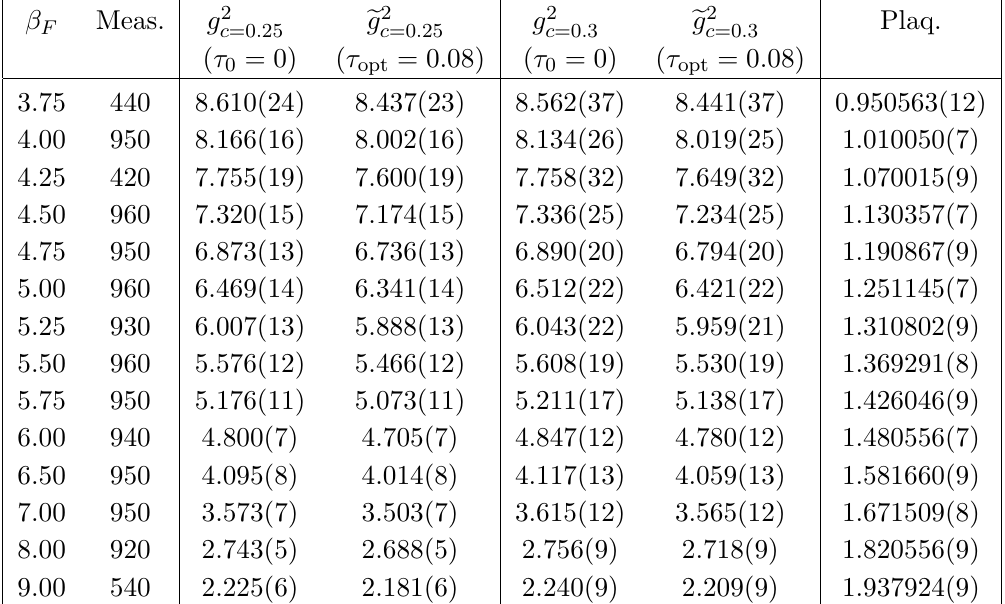
Table 9 . 32 4 lattice ensembles used in this work, with columns as in table 3.